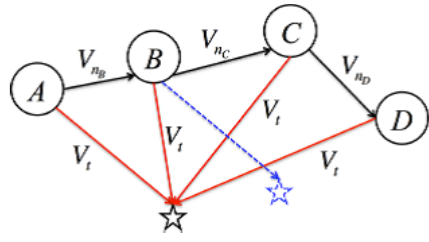
Fig. 18. PAs update a target vector when they